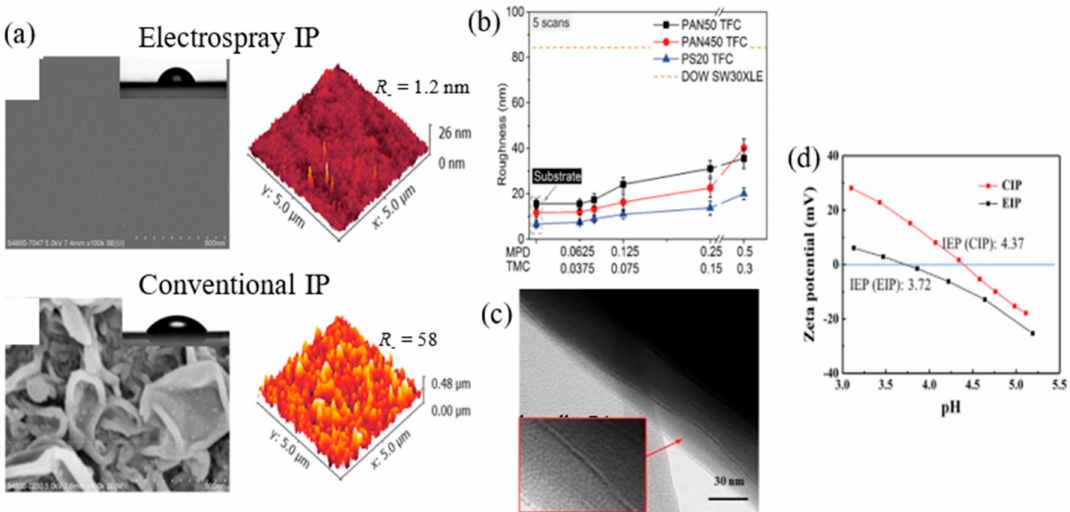
( a ) Comparison of SEM and AFM images of TFC membrane surface formed via electrospray-based IP and conventional IP process [126]. ( b ) RMS surface roughness of electrospray-based TFC membranes fabricated at di ff erent MPD: TMC concentration ratio [31]. ( c ) TEM image showing the lamellar PA structure of electrospray IP-based membrane [127]. ( d ) Zeta potential of TFC membranes fabricated via two techniques (note: CIP, conventional IP; EIP, electrospray IP)